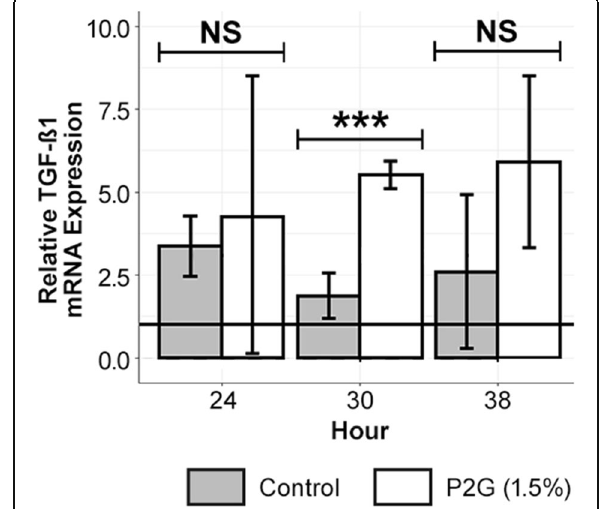
Fig. 3 Exploratory investigations suggest P2G possibly effects preosteoblasts ’ TGF- β 1 mRNA expression. Experimental data, which includes water controls, suggests that P2G may upregulate TGF- β 1 gene expression at hour 30 (Welch ’ s t -tests). The solid line is the normalized mean of hour 0 pre-treatment baseline measurements. Control refers to study arms treated with water. The graph displays qRT-PCR mRNA expression. NS p >0.05, * p <0.05, ** p <0.01, *** p <0.001